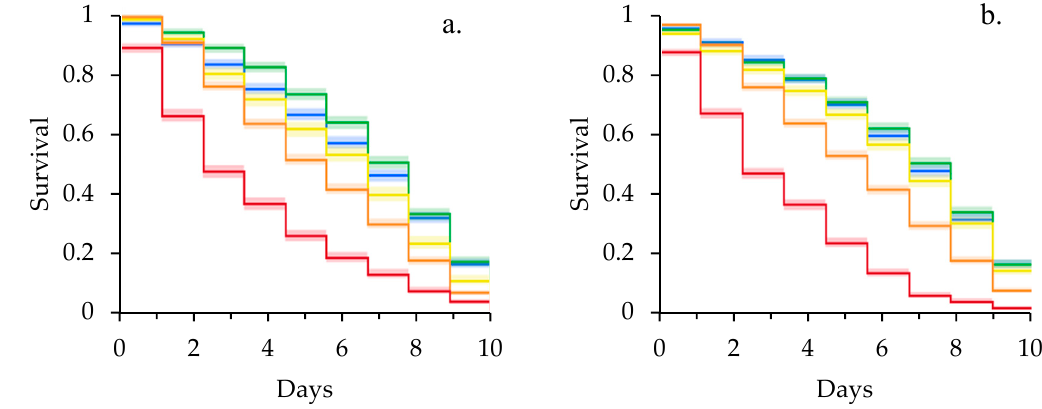
Figure 1. Kaplan ‐ Meier survival curves for adult bees fed clothianidin reared in ( a ) pollen deprived and ( b ) pollen supplemented colonies. Shading represents 95% Confidence Intervals. Blue = 0 μ g/L, Green = 10 μ g/L, Yellow = 40 μ g/L, Orange = 200 μ g/L, Red = 400 μ g/L.